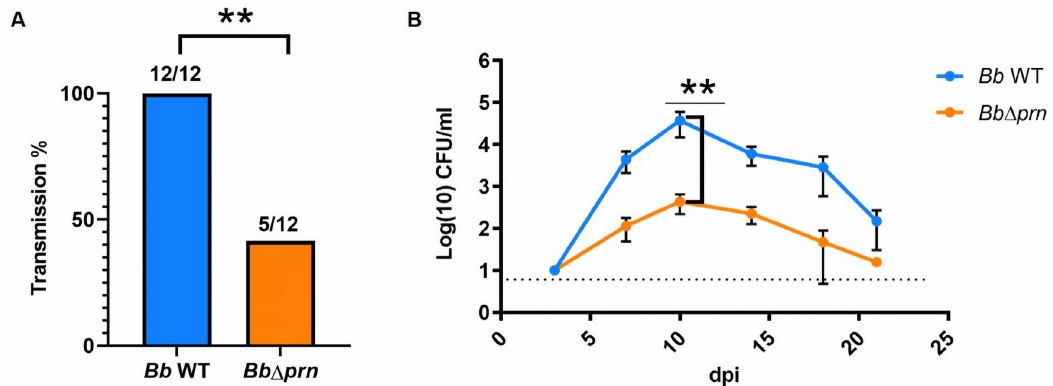
Fig 1. B . bronchiseptica PRN contributes to bacterial transmission and shedding. A) Transmission rates among Bb WT (blue) or Bb Δ prn (orange) inoculated mice. B) Number of bacteria shed from the external nares of Bb WT infected mice (blue) and Bb Δ prn infected (orange) mice. Twelve mice were utilized in each time point per group. The dashed lines show the detection limit in the experiment. Error bars show the standard error of mean. Statistical significance was calculated by using chi-square test in panel A and two-way ANOVA in panel B. �� p < 0.01.